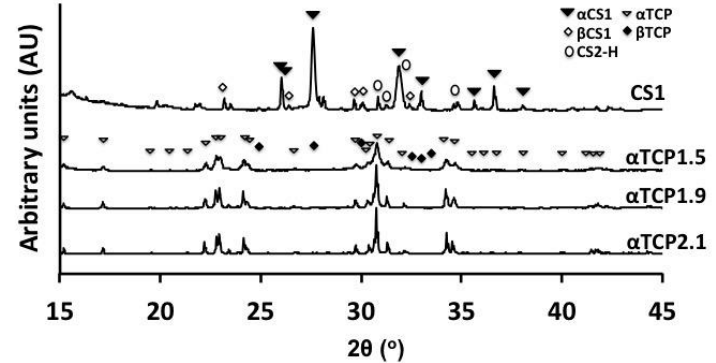
ff raction of calcium salt precursors used to make Figure 4. X-ray diffraction of calcium salt precursors used to make PMCs. Figure 4. X-ray di